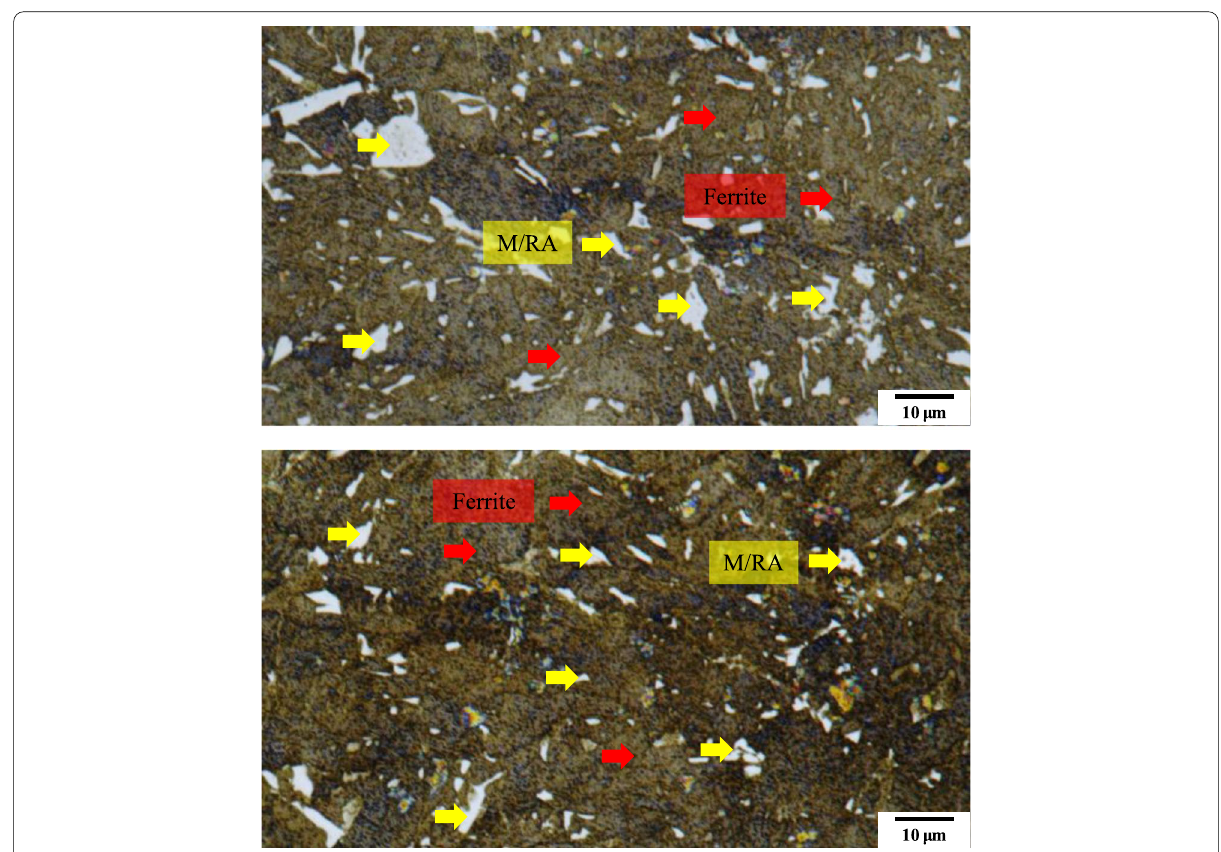
Fig. 4 Optical micrographs subjected to Second condition of LePera etching of 4Nb specimen. In the same color as in the primary condition, M/RA is observed. Matrix(Ferrite) is dark brown, which means it is